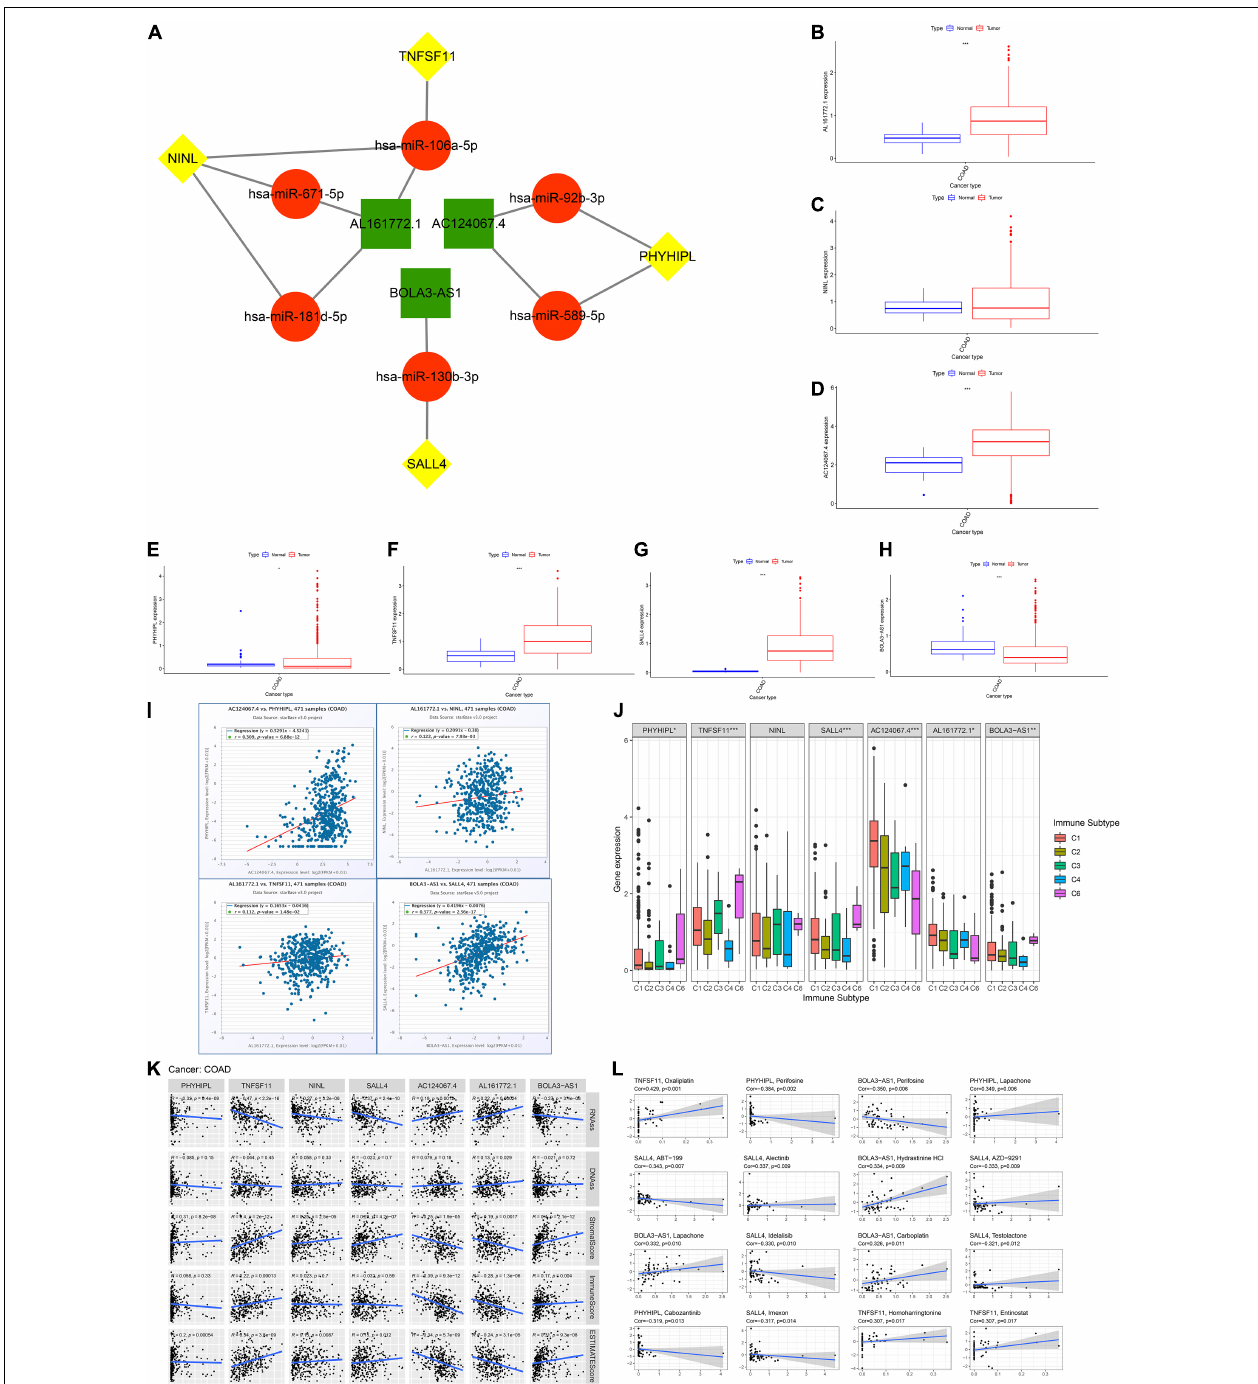
FIGURE 5 | Competing endogenous RNA (ceRNA) network construction and immune, cancer stemness, and drug sensitivity analysis. (A) The genome instability-related ceRNA network in colon adenocarcinoma (COAD) based on ENCORI. (B – H) The differential expression analysis included three lncRNAs ( BOLA3-AS1 , AC124067.4 , AL161772.1 ) and four target mRNAs ( NINL , SALL4 , TNFSF11 , PHYHIPL ) by Mann-Whitney U test. (I) The correlation between the expression of each lncRNA and its target mRNAs based on ENCORI. (J) The association between the seven gene expression and five immune subtypes in COAD. (K) The association between the seven-gene expression and cancer stemness based on mRNA expression (ssRNA) and DNA methylation patterns (DNAss); the association between the seven-gene expression and the ESTIMATE immune score, stromal score, and ESTIMATE score. (L) The association between the seven-gene expression between drug sensitivity based on the NCI60 database (top 16 ranked by correlation). * p < 0.05, ** p < 0.01, and *** p < 0.001.